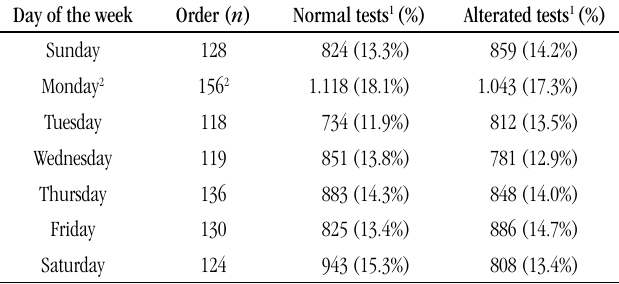
tABLE 4 – Distribution of results of laboratory tests ordered for patients admitted in intensive care unit, sorted by days of the week Day of the week Normal tests 1